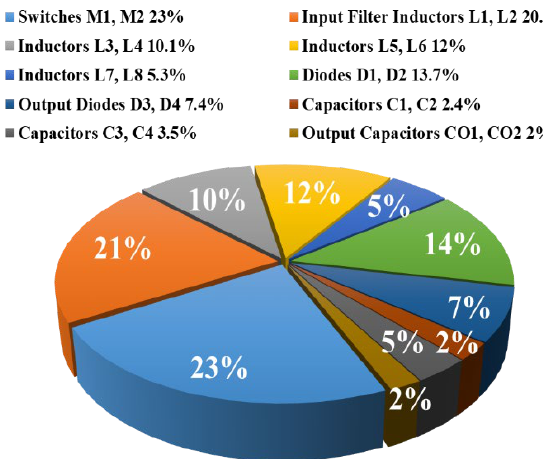
Figure 22. Voltage gain versus duty cycle: the red, blue, and black graphs respectively correspond to the proposed converter, the converter in [25] and the converter in [22,23].